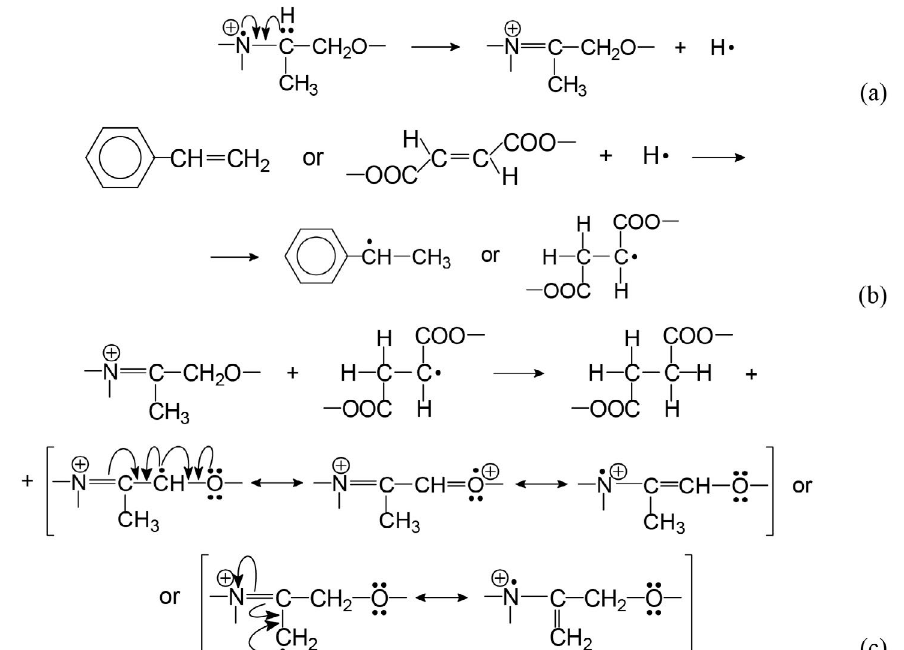
Scheme 6. A reaction cycle explaining the elongation of gelation